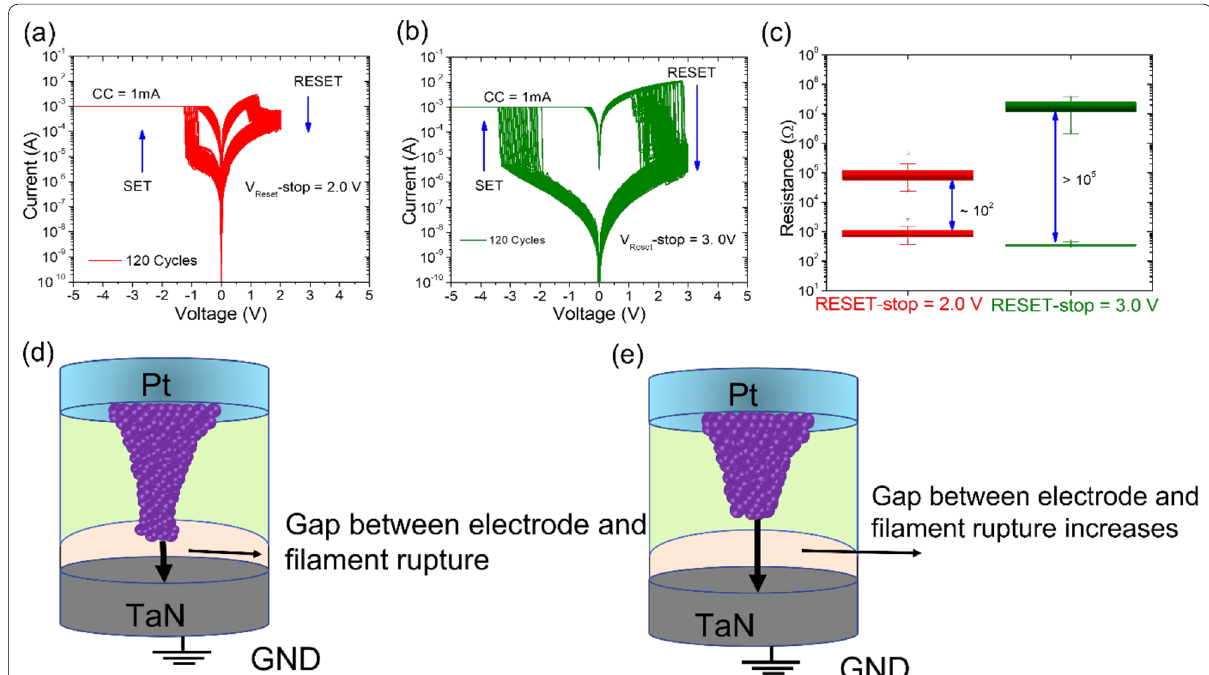
Fig. 4 a Typical bipolar I–V characteristics and b comparison of ON/OFF resistance ratios of the Pt/HfO 2 /Al 2 O 3 /TaN memristive device under different reset-stop voltages, i.e., 2.0 V and 3.0 V, with fixed set voltage of 5 V. c , d Schematic illustration of switching mechanism of OFF state + + − at different reset-stop voltages (2.0 V and 3.0 V) for the prepared Pt/HfO 2 /Al 2 O 3 /TaN memristive